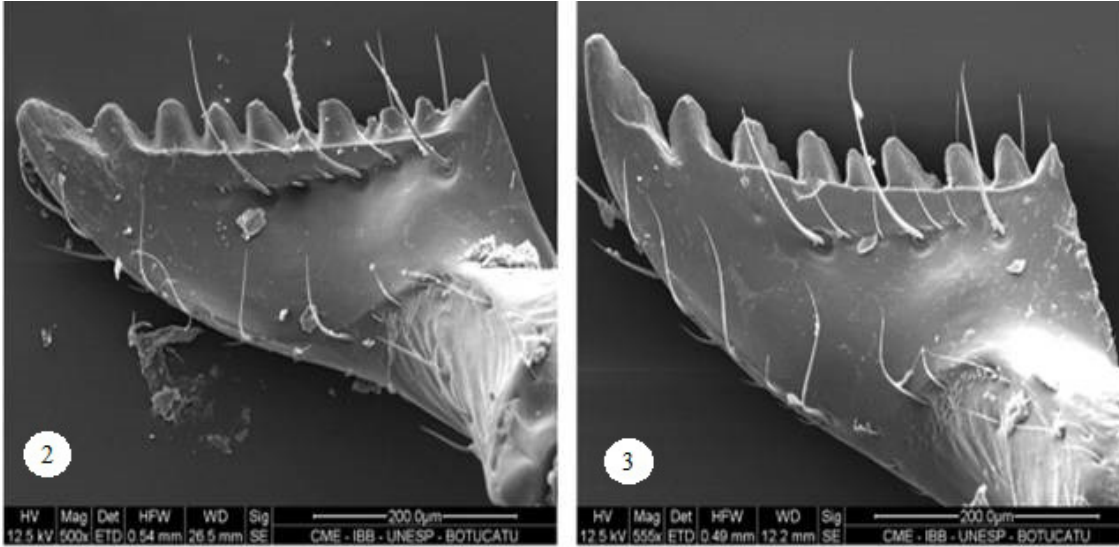
Figs 2-3. ventral side of right mandibles of Atta bisphaerica (2) and Atta sexdens rubropilosa (3) gardeners.